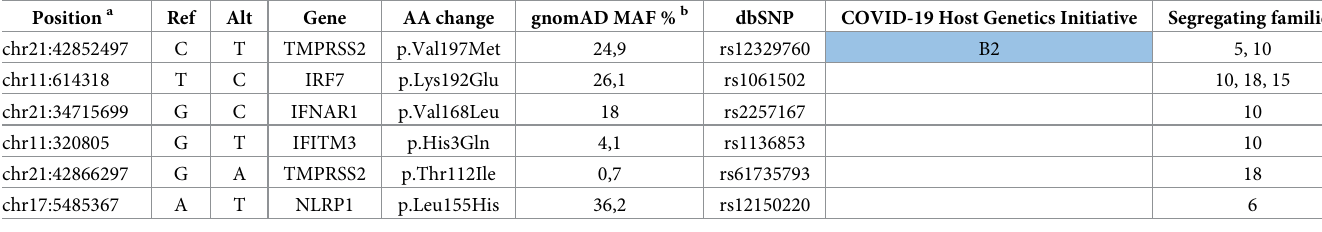
Three families (n˚8, n˚9, n˚12) carried several variants in different genes. Some of these var- iants (total four out of eighteen) were in common between different families: the p.His843Arg in IFIH1 gene, three variants in FYCO1 gene (p.Arg250Gln, p.Gly321Ala and p.Asn1001Glu) and the last one substitution was also identified as a risk variant by the HGI study. The other fourteen variants were non-shared between families and present in single ones. Among them, we detected two risk variants co-segregating with COVID-positive status in families n˚14 and n˚12 (the p.Arg447Cys in FYCO1 gene and the p.Ala9Gly in SLC6A20 gene, respectively) previously reported in the HGI study. In family n˚12, also the p.Gln11Leu in TLR7 and p.Ala114Ser in IL1A co-segregated with COVID-19 positive status. Two other variants in family n˚10 (p.Ser669Asn and p.Ser662Phe in FYCO1 gene) were exclusively detected in this family in cis , both with a frequency of 0,15% in gnomAD.